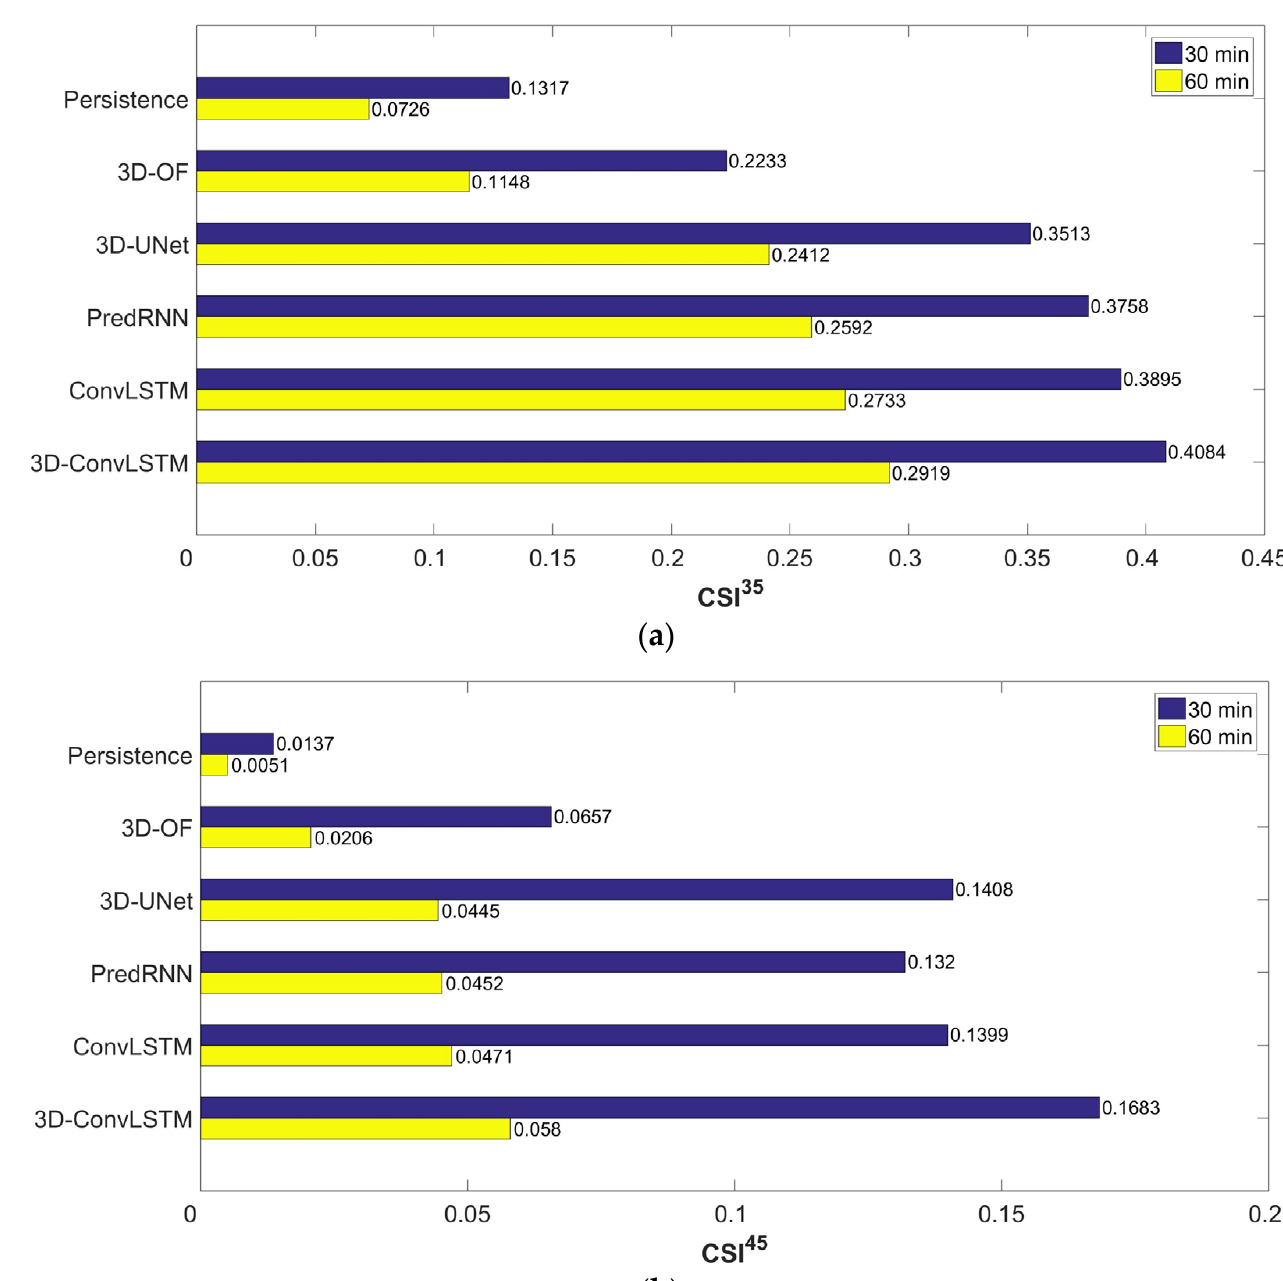
( b ) Figure 3. Critical success index ( CSI ) curves against different lead times at ( a ) 35 dBZ threshold and ( b ) 45 dBZ threshold. In addition, the CSI 35 and CSI 45 scores computed for the nowcasts obtained by the six models for lead times of 30 and 60 min are shown in Figure 4a,b, respectively. As can be seen, the proposed 3D-ConvLSTM exhibits clear superiority. It achieved higher CSI 35 scores with relative improvements of 4.9% and 6.8% over those of ConvLSTM for lead times of 30 and 60 min, respectively. In addition, the CSI 35 score of the proposed method